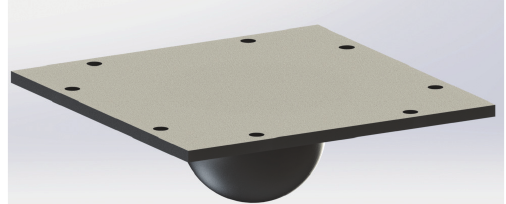
Figure 4. Top part of air bearing.